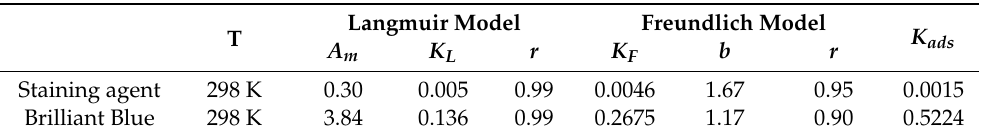
Table A2. Parameters of the Langmuir and Freundlich adsorption model for the staining agent and the Brilliant Blue dye on powdered adhesive